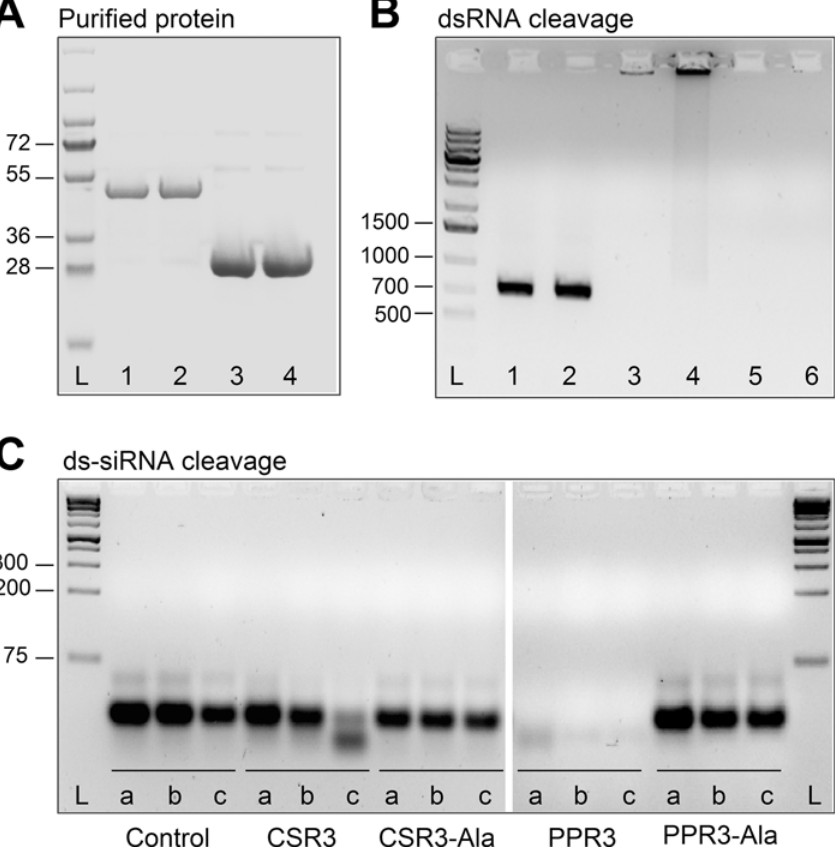
Fig 2. Endoribonuclease activity of PPR3 and CSR3 on long and short dsRNA. ( A ) His-tagged proteins PPR3 (lane 1), PPR3-Ala (lane 2), CSR3 (lane 3), and CSR3-Ala (lane 4) expressed in E . coli and analyzed by SDS-PAGE. L, Prestained protein ladder (Fermentas). Expected sizes of PPR3 and PPR3-ala ~ 40 kDa; CSR3 and CSR3-Ala ~ 26 kDa. ( B ) CSR3 (lane 3), PPR3 (lane 5), and PPR3-Ala (lane 6) processed long dsRNA (700 bp) following incubation at 37°C for 30 min, as detected by agarose gel electrophoresis, whereas CSR3-Ala (lane 4) bound dsRNA but was not able to process it (dsRNA remained in the well of the gel). The eluate (lane 2) and the reaction buffer (lane 1) were used as negative controls. Results (lane 3) indicate that the amount of dsRNA used in the reaction exceeded the catalytic activity of CSR3 under the prevailing experimental conditions and the unprocessed portion of dsRNA bound but not processed by CSR3 remained in the well (lane 3). Furthermore, the results indicated that the mutations introduced to PPR3 did not fully abolish the catalytic activities on long dsRNA. L, 1-kb DNA size marker. ( C ) Endoribonuclease activity of 0.5 μ M CSR3, PPR3, CSR3-Ala, and PPR3-Ala on synthetic double-stranded siRNA (24 bp) in a 3-h incubation at 37°C at pH 6.5 (a), 7.5 (b), or 8.5 (c). Samples were analyzed by electrophoresis using a 4% agarose